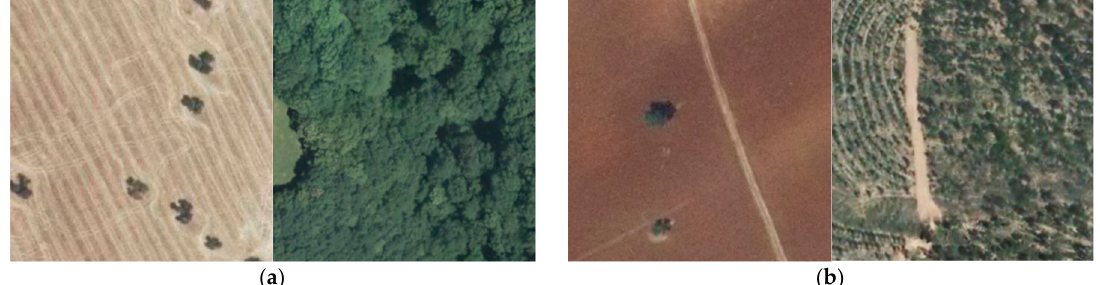
Figure 1. Examples of tiles extracted from the labelled dataset ( a ) Category 1—“No road” and ( b ) Category 2—“Road